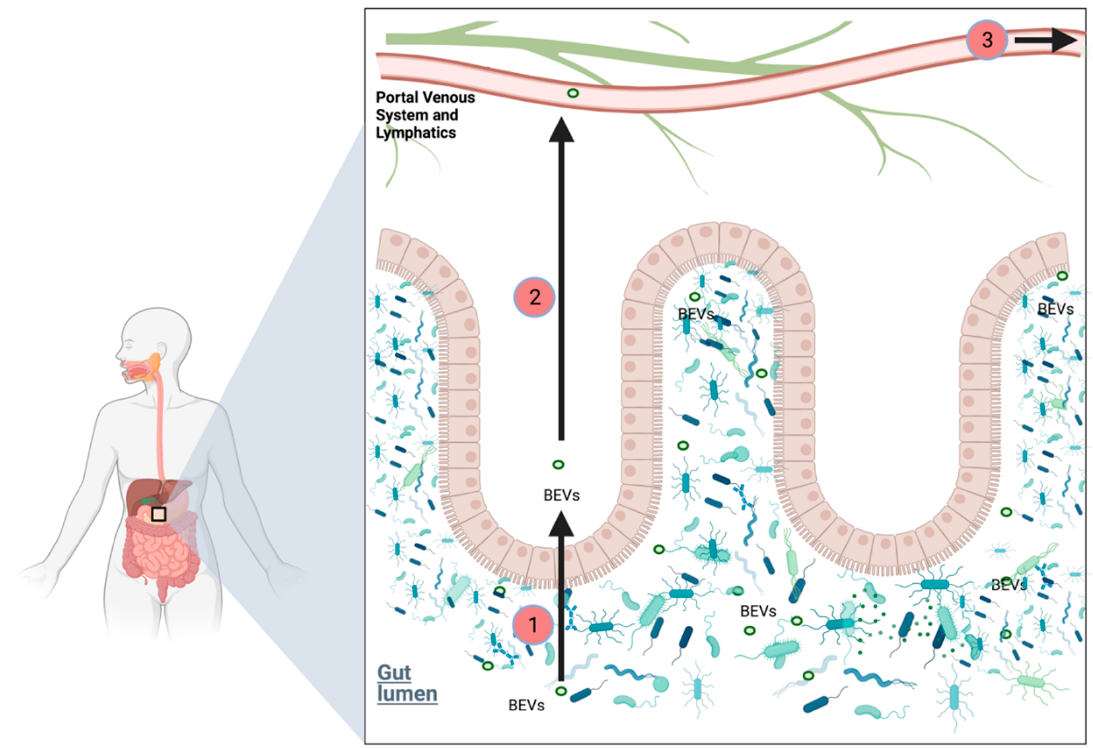
Figure 6. Bacterial extracellular vesicles produced by gut bacteria cross the gut epithelial barrier to the submucosa via transcellular and/or paracellular transport, exacerbated by disruption of the gut wall barrier (1). They subsequently enter the portal circulation and/or lymphatics (2) and in doing so may provide a means for inter-kingdom communication with site specific microbiomes such as the PDAC microbiome (3). The resultant affect may be one of immunomodulation locally at the tumour microbiome. BEVs in the circulation may be used as biomarkers of PDAC.